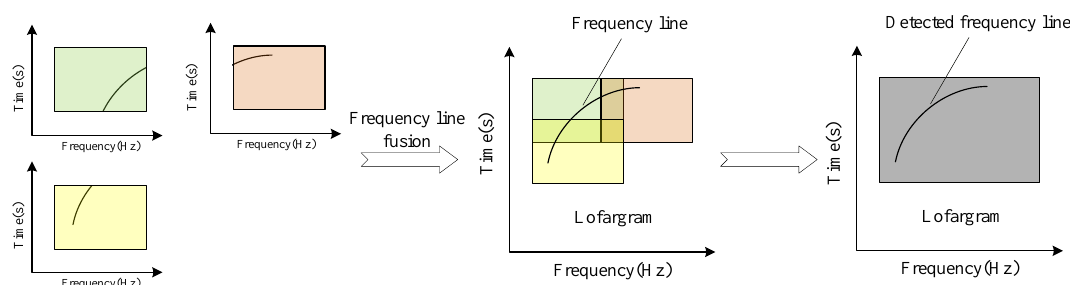
p , q − 1 p , q p , q with W of W r j right